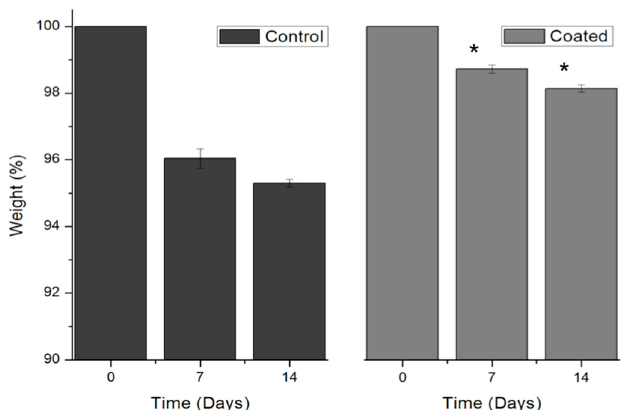
Figure 6. Weight (%) of coated salmon fillets and the untreated control stored at 2.0° ± 0.5° for 14 days. * Significant difference in coated fillets ( p < 0.05) between the treatments ( n = 3).